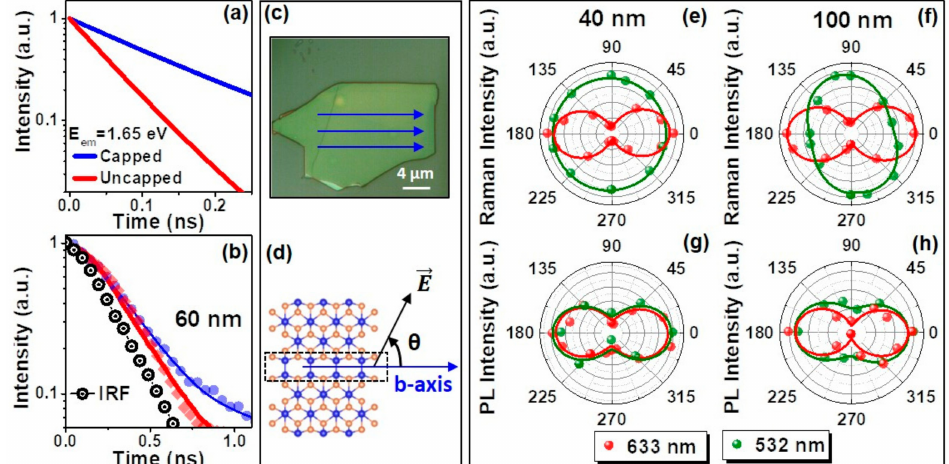
Figure 5. ( a ) Representative reconvoluted room-temperature PL decay transients at 1.66 eV emission, and ( b ) measured PL decay transients of a capped (blue) and as-exfoliated uncapped GaTe flake (red) acquired using a pulsed diode laser source [ λ = 405 nm (3.06 eV), ~50 ps full width at half maximum (FWHM)]. The measured PL decays were fitted using reconvolution analysis based on the instrument response function (IRF) (solid lines) [23]. ( c ) Optical image of a 100 nm-thick GaTe flake shown along with the b -axis (blue lines) identified using TEM; ( d ) Schematic showing the angle ( θ ) between the laser polarization direction and the crystal b -axis used for polarization-dependence measurements. ( e , f ) Polarization dependence Raman peak (115 cm − 1 ) intensity and ( g , h ) PL peak (1.66 eV) intensity polar plots of 40 nm and 100 nm thick HSQ-capped flakes, respectively, for the excitation wavelengths of 633 nm (red) and 532 nm (green). A high PL intensity was observed when the electric field of the excitation laser light was parallel to the b -axis of HSQ-capped GaTe ( θ = 0 ◦ ), in agreement with TEM (cid:16) (cid:17) cos 2 θ analysis. The equation, y = y 0 + A was used for fitting the polar